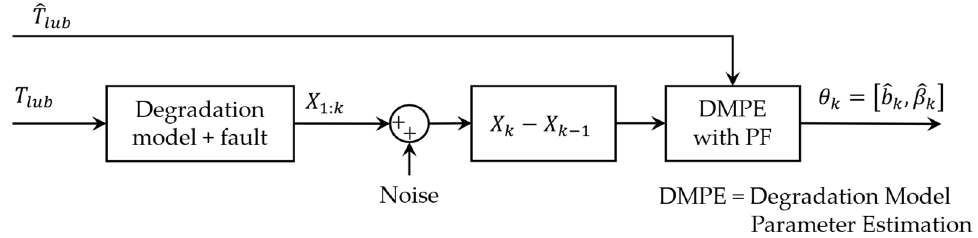
Figure 12. Flow of one-step online parameter estimation for degradation model.